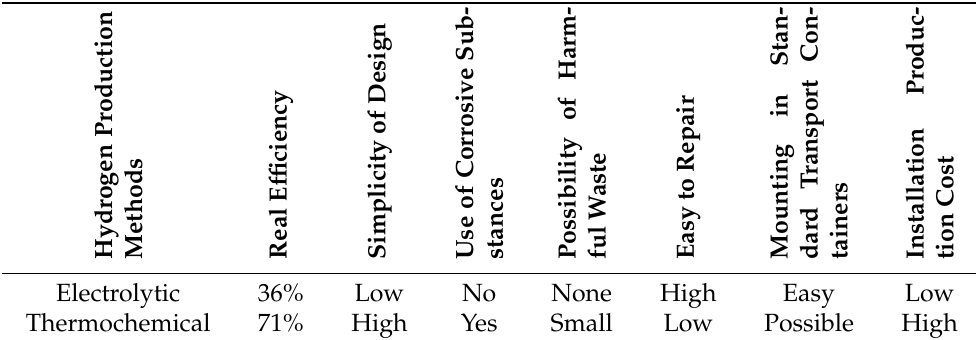
Table 1. Comparison of hydrogen production with electrolytic and thermochemical methods* in mobile